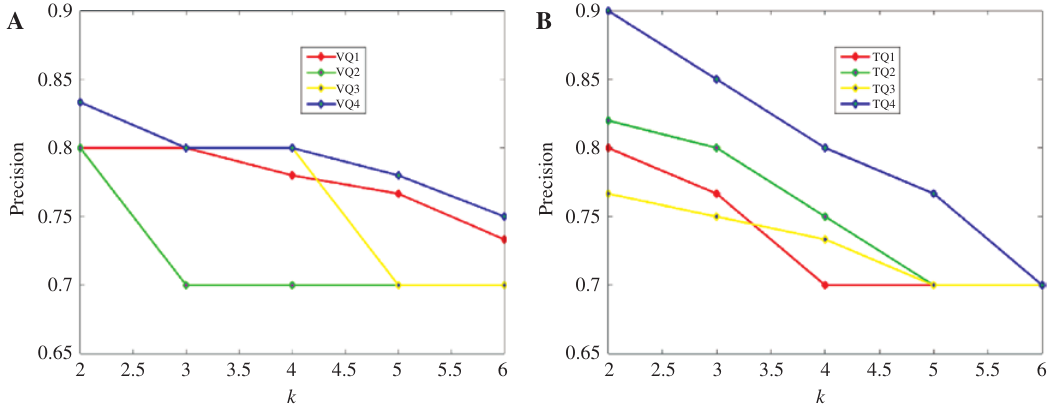
Figure 6: Precision Graph. (A) Video queries. (B) Text